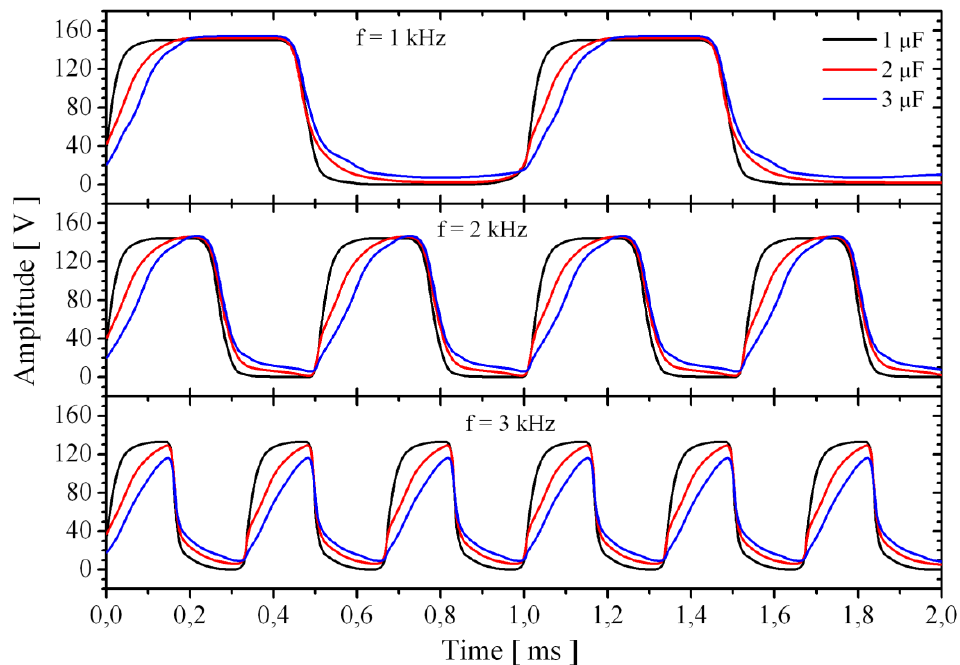
Figure 4. The output signal with a capacitive load (transducer) of 1, 2 and 3 μ F (150 V , for 1, 2 and 3 kHz) connected to the driver. p-p